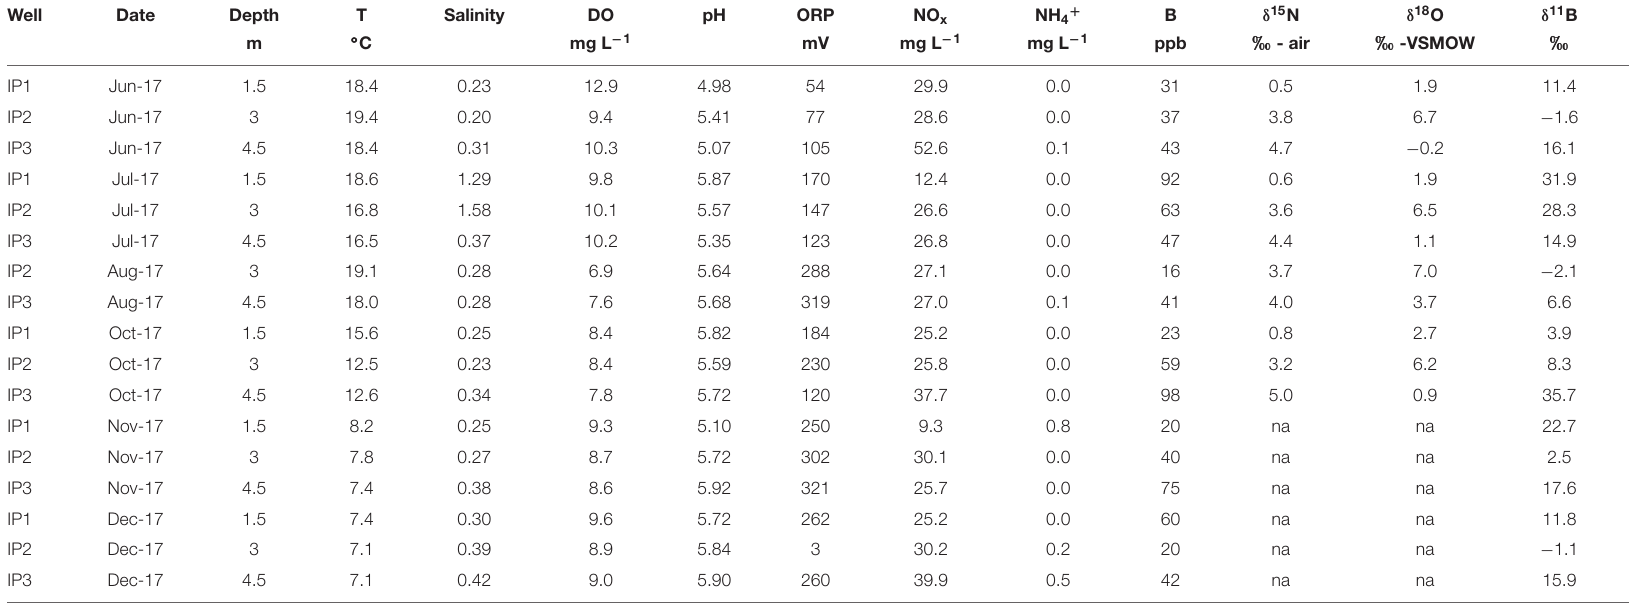
TABLE 4 | Iron Pier Beach coastal groundwater samples collected in 2017.